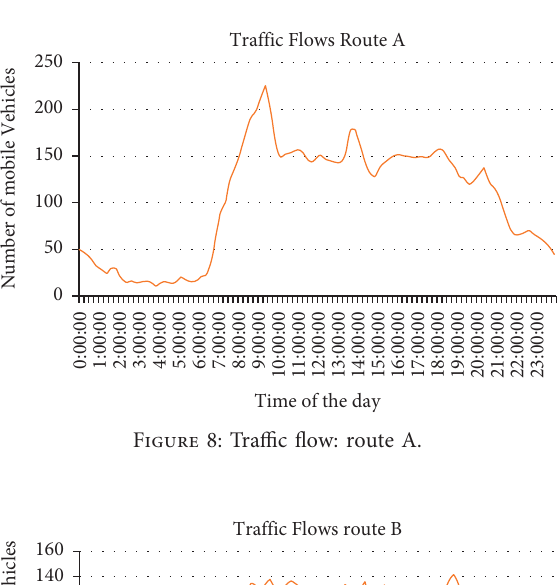
Figure 7: Vehicle densities.